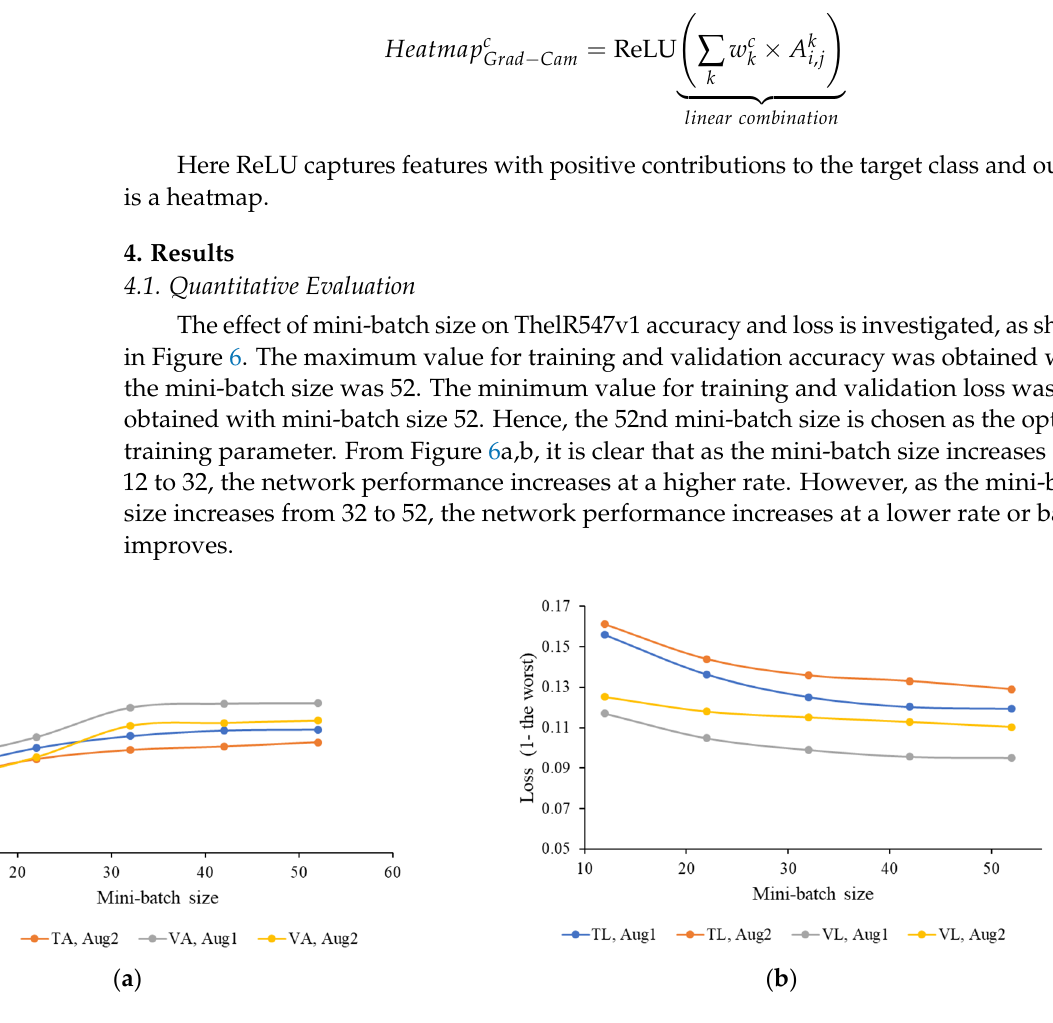
Figure 6. Relationship between mini-batch and network performance. ( a ) Mini-batch size vs. accuracy. ( b ) Mini-batch size vs. loss.